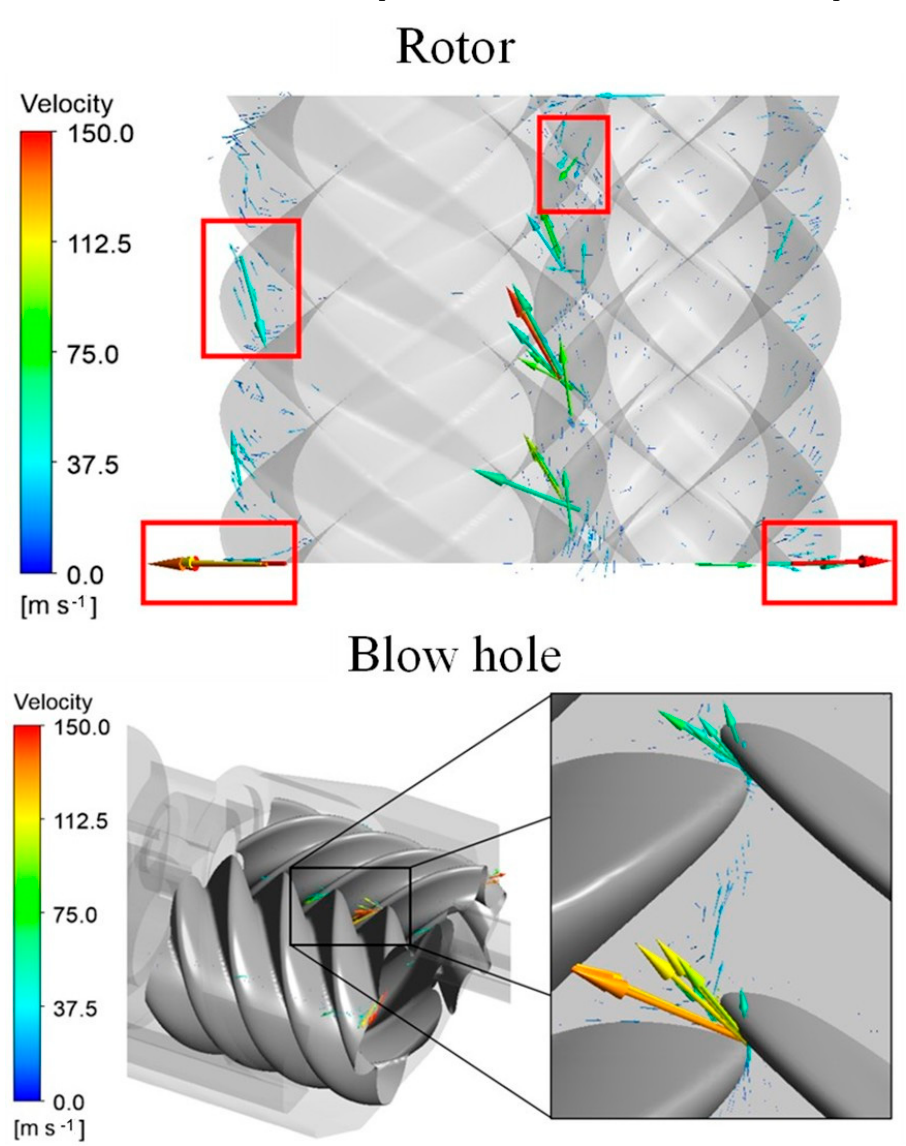
Figure 14. The leakage fl ow at rotors and blow hole.